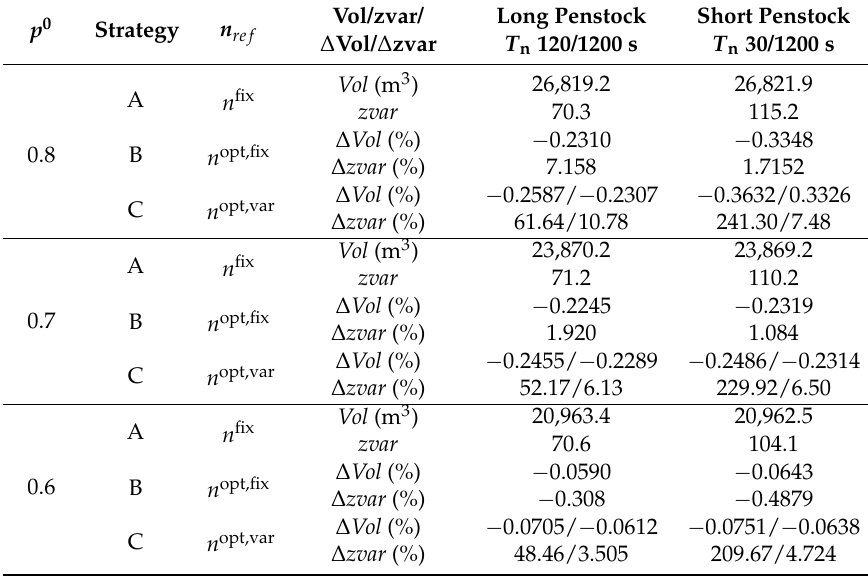
Table 8. Vol and zvar with the three control strategies, and different initial PSHP powers p 0 , n fix = 1.0882